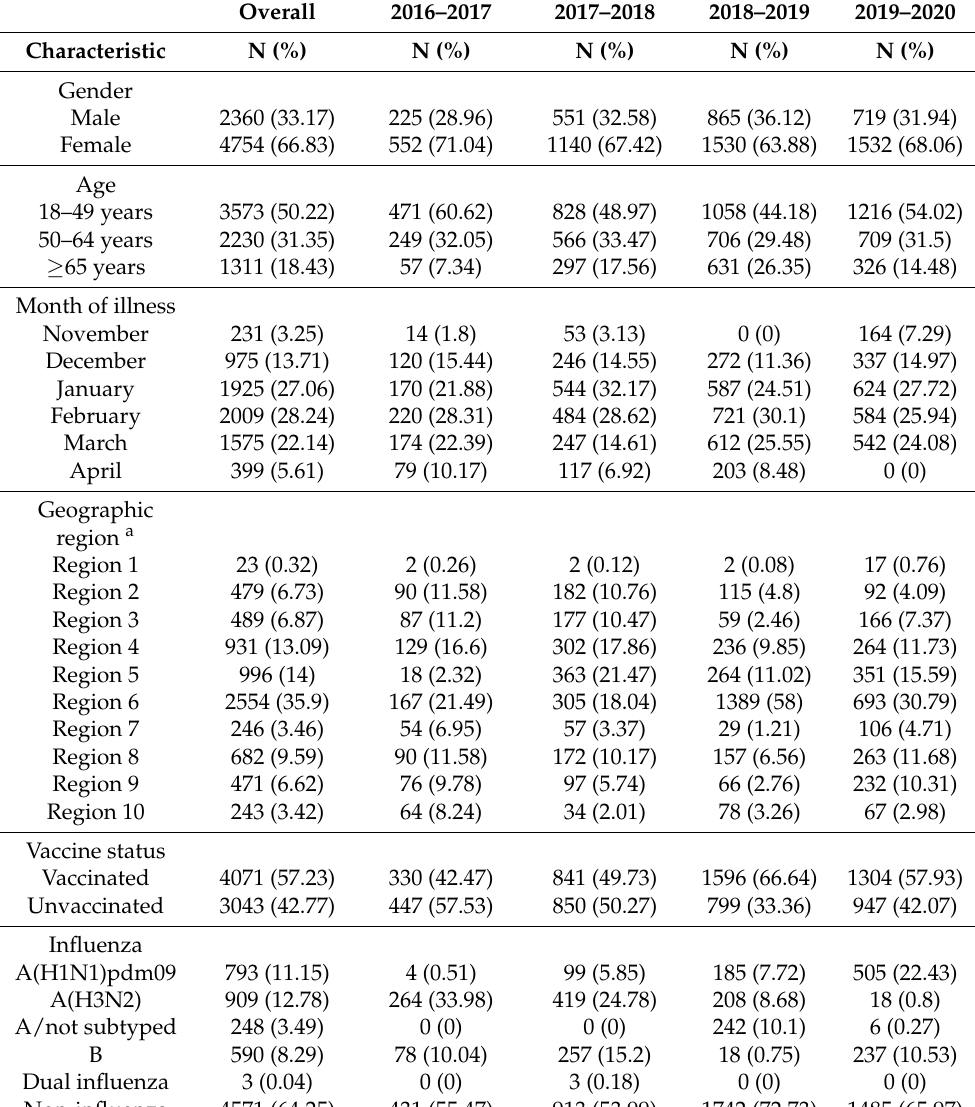
Table 1. Characteristics of study population used for vaccine effectiveness analysis over four influenza